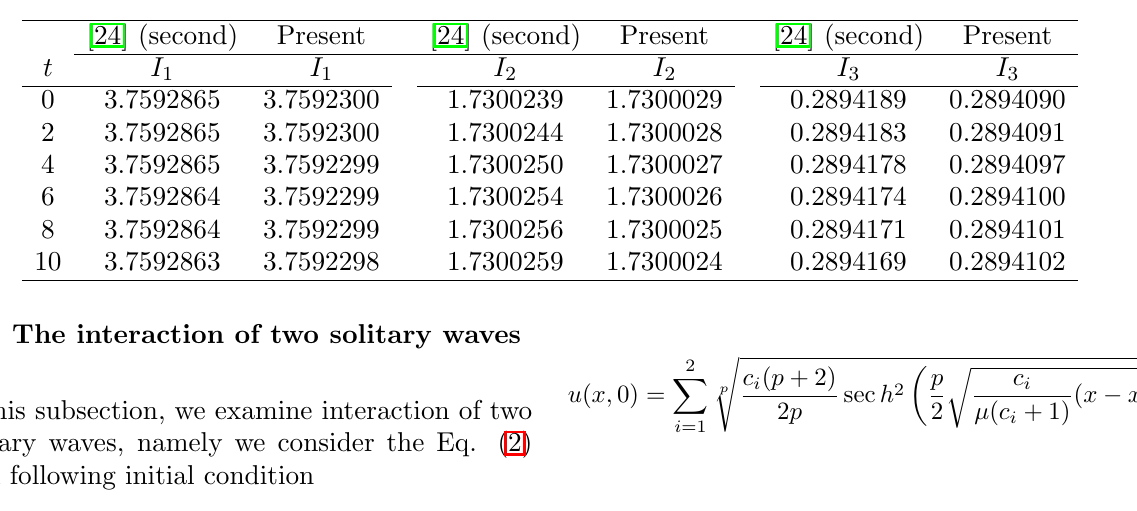
Table 5. Invariants and their comparison on 0 ≤ x ≤ 100 for N = 250, ∆ t = 0 . 01, µ = 1 ,p = 4, c = 0 .